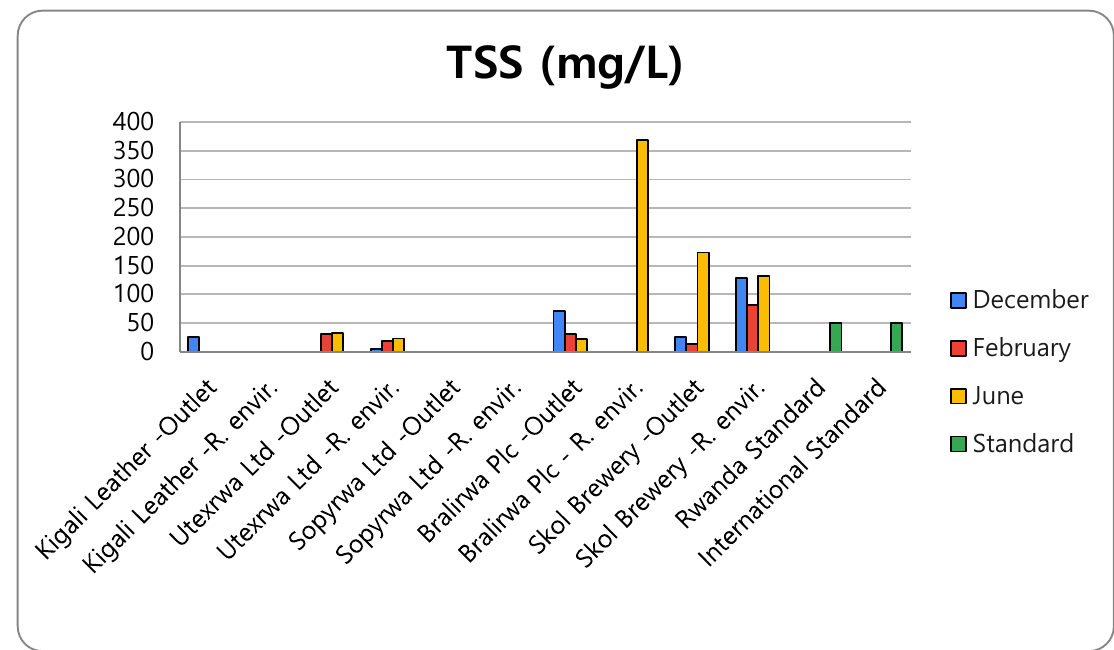
Figure 6. TSS (mg/L) levels discharged per site .